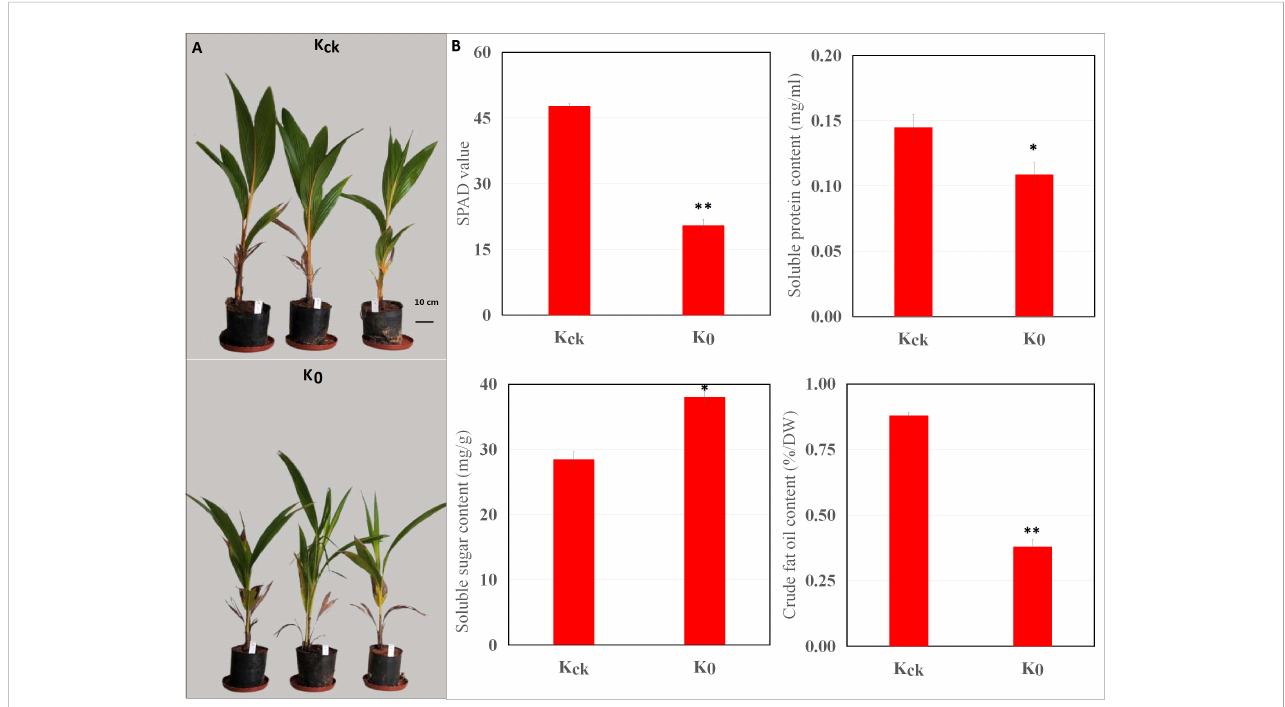
FIGURE 1 Effects of K + de fi ciency on coconut seedlings. (A) Phenotype of coconut seedlings after 30 days of K + treatment. (B) Changes in SPAD, SP, SS, and CF contents under K + de fi ciency for 30 consecutive days. * P ≤ 0.05, ** P ≤ 0.01. Bars represent